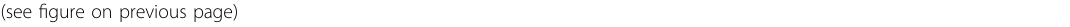
Fig. 5 Crystal internalization induces LDH release and apoptosis in HK2 cells. Control (noncrystal) CaP, CaOx, and CaP + CaOx (mixed) crystals were introduced into HK2 cells for 24 h. Cell death was determined by A DAPI staining and B Annexin V labeling. C Cell viability was determined relative to control (100%) by methylene blue staining. D LDH release was determined by measuring conversion of purple tetrazolium salt into red formazan. E Necrosis was detected with PI staining. Statistically signi fi cant differences are indicated (mean ± SEM). Experiments were performed in triplicates. Data are presented from three individual experiments ( n = 3). Two-tailed t test was used for statistical comparison. Levels of signi fi cance are indicated as * p < 0.05 and ** p < 0.01 as shown in the bar diagrams. Scale bar, 100